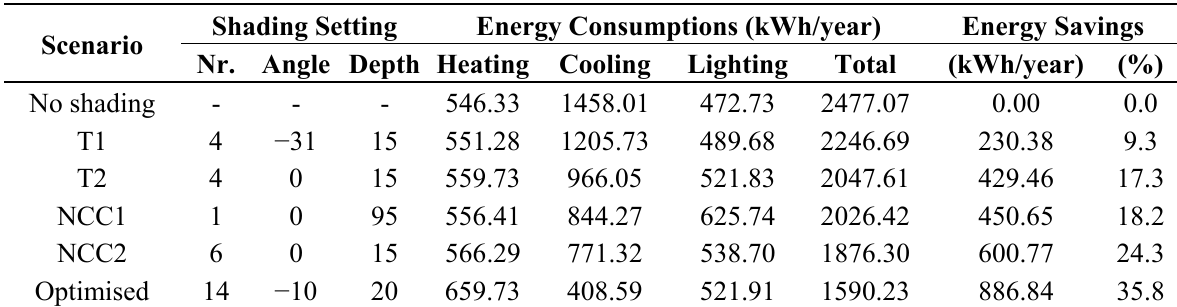
Table 3. Result summary and comparison for all simulated scenarios. Energy consumption.